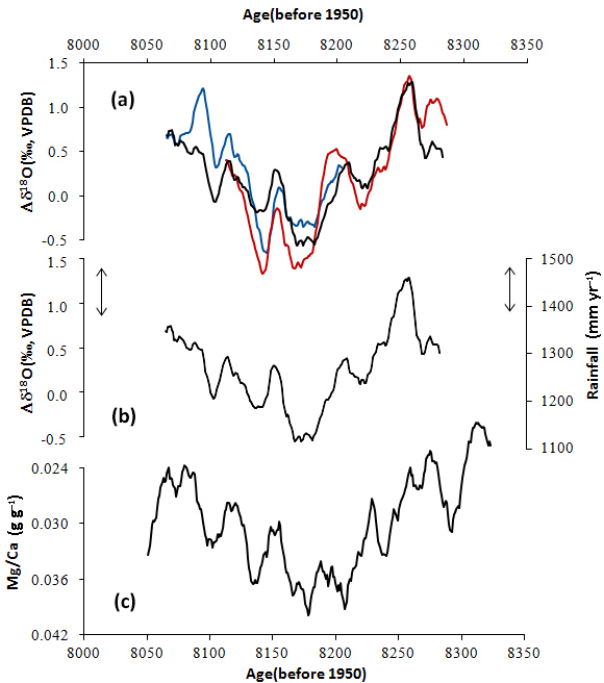
Figure 3. The 10-year moving average records during the 8.2kaBP period. (a) (cid:49)δ 18 O records between DA and HS4 with unchanged chronology (black), shifting DA 50 years younger (blue) and 50 years older (red); (b) (cid:49)δ 18 O record between DA and HS4 and re- constructed annual rainfall in southwest China with error bars indi- cated; (c) Mg / Ca ratios of HS4 shown on inverted scales, which reveals a similar trend to the rainfall sequence, increasing the confi- dence of the quantification of the reconstructed